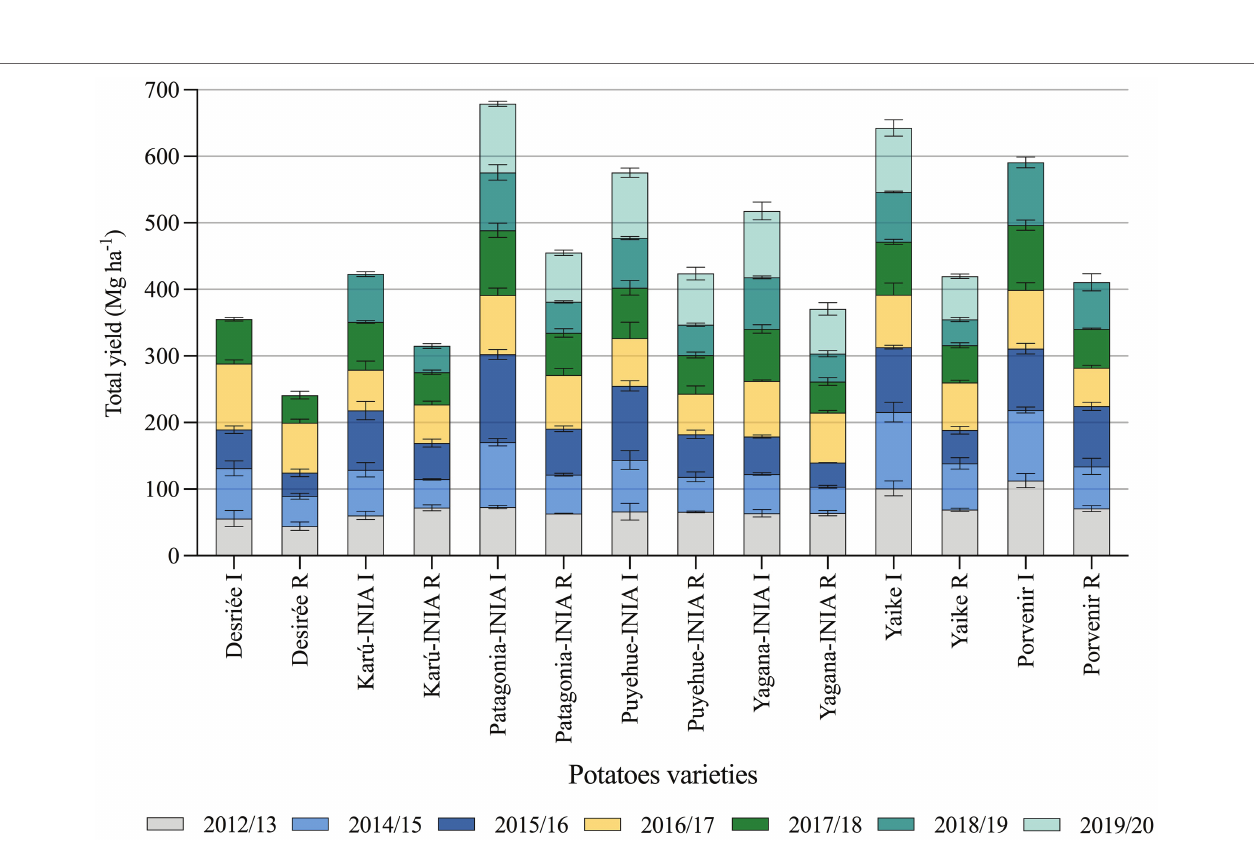
FIGURE 4 | Temporal tuber yield of seven potato varieties under irrigation and rainfed conditions from 2012–13 to 2018–19 season. Desiree and Porvenir with five and six seasons, respectively. Error bars indicate SE. I, irrigation condition; R, rainfed